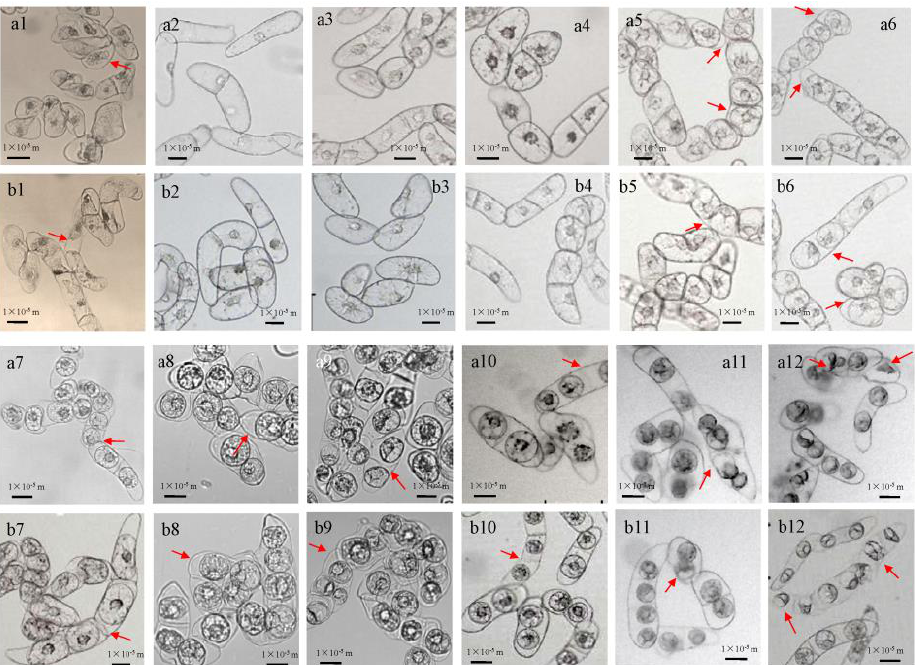
Figure 5. Morphological changes of BY-2 cells under different mannitol concentrations. 1: 0.0 M, 2: 0.1 M, 3: 0.2 M, 4: 0.3 M, 5: 0.35 M, 6: 0.4 M, 7: 0.5 M, 8: 0.6 M, 9: 0.7 M, 10: 0.8 M, 11: 0.9 M, 12: 1.0 M. ( a1 – a12 ): BY-2 cells were suspended in centrifuge tubes containing mannitol solution for 2 h